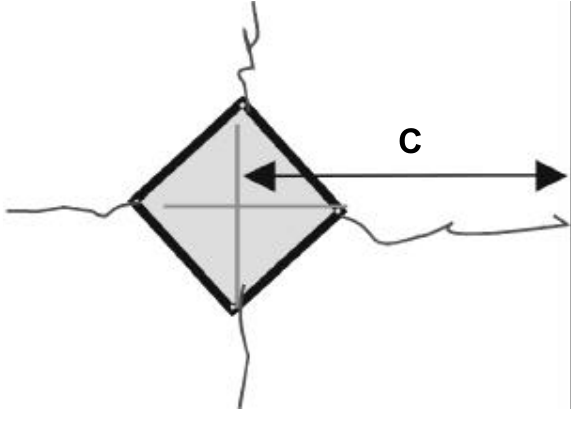
FIGURA 1- Esquema da indentação evidenciando a formação de